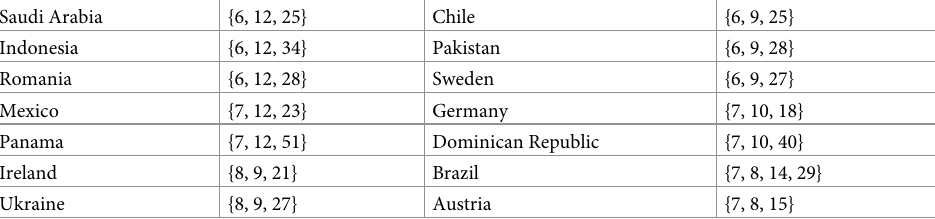
Table 5. Slightly modified or shared rhythms among countries.